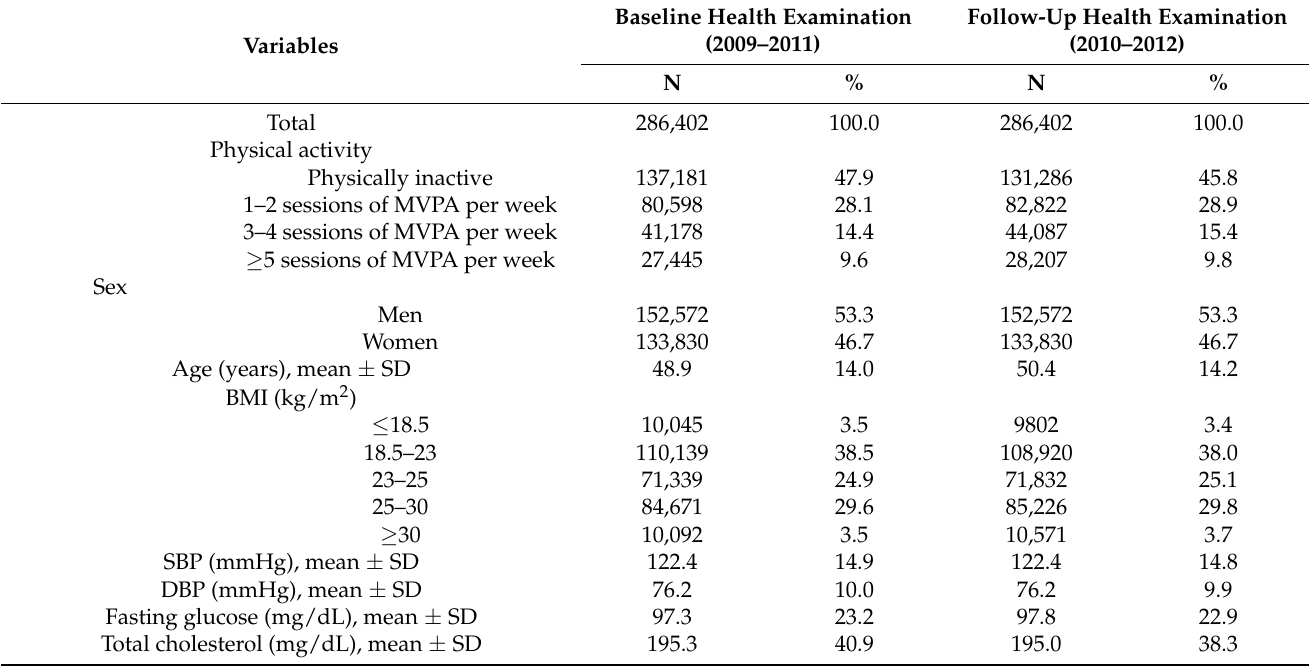
Table 1. General characteristics of study participants who received two consecutive biennial national health screenings in